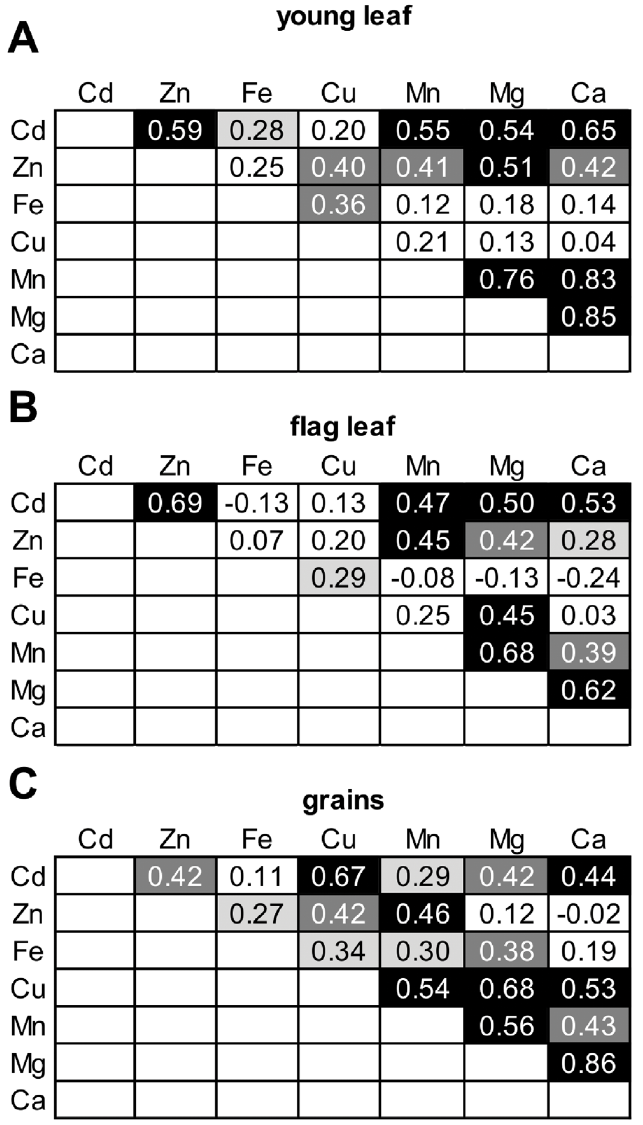
Fig 4. Between-element correlations of concentrations in tissues of barley ILs. Pearson correlation coefficients ( r ) are given for (A) the young leaf, (B) the flag leaf and (C) grains. Values are based on least- square means of 54 ILs and the recurrent parent Scarlett. Correlations exhibiting r > |0.27|, |0.35| and |0.44| are statistically significant at P < 0.05 (light grey), 0.01 (dark grey) and 0.001 (black), respectively, according to a two-tailed distribution and n = 55 observations. Measurements were from the same experiment as shown in Fig